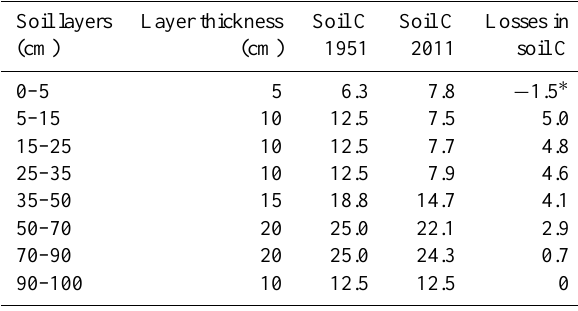
Table 1. Soil C content in the soil profile during 1951 to 2011 esti- mated by the vegetation fitted model,kgCm − 2 . Soil